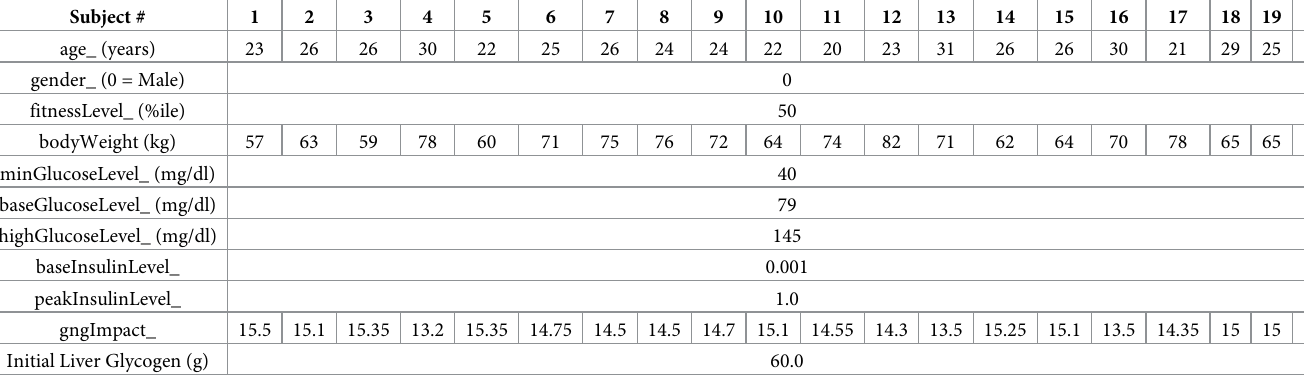
Fig 2. Average BGL measurements (After Conversion to mg/dl) reported in [51] and [80]. https://doi.org/10.1371/journal.pone.0209725.g002 parameters (that differed from the default values) for the simulated subjects are shown in Table 8. In each simulation, the initial glycogen store in the Liver was set to 60 grams so that very little glycogen was left in the Liver by the time the exercise event began at 12pm. The gngImpact_ parameter was set to values between 13.2 and 15.5 so as to appropriately limit the glucose production via gluconeogenesis during the exercise event. Table 8. Configuration parameters for simulations for a single exercise event at intensity 58% VO 2 max